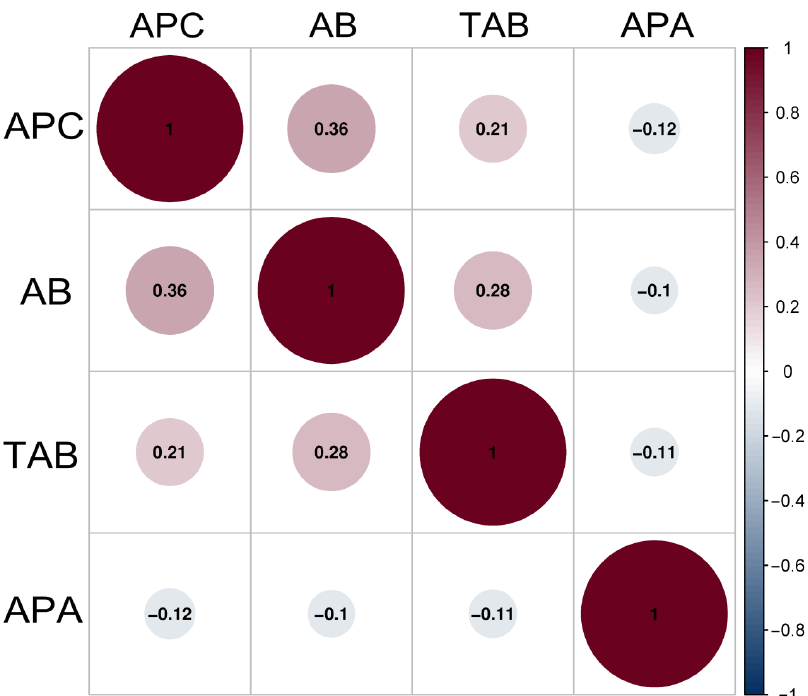
Figure 2. Correlation between the aerobic plate count, aerobic Bacillus count, thermophilic aerobic Bacillus count, and alkaline phosphatase activity of pasteurized milk samples. The p values are shown in circles. All the p values are < 0.05. APC: aerobic plate count; AB: aerobic Bacillus count; TAB: thermophilic aerobic Bacillus count; APA: alkaline phosphatase activity. For raw milk, there were positive correlations between the aerobic plate count, the aerobic Bacillus abundance, and the alkaline phosphatase activity (all p < 0.05), and the aerobic Bacillus abundance had positive correlations with the thermophilic aerobic Bacillus count and the alkaline phosphatase activity (both p < 0.05). Thermophilic aerobic Bacillus count was irrelevant in raw milk in the determination of correlations with the aerobic plate count and the alkaline phosphatase activity, respectively (both p > 0.05). The largest p value (0.29) was observed for the positive correlation between the aerobic plate count and the aerobic Bacillus abundance. For pasteurized milk, there were positive correlations between the aerobic plate count, the aerobic Bacillus abundance, and the thermophilic aerobic Bacillus count (all p < 0.05); however, the alkaline phosphatase activity had negative correlations with the aero-